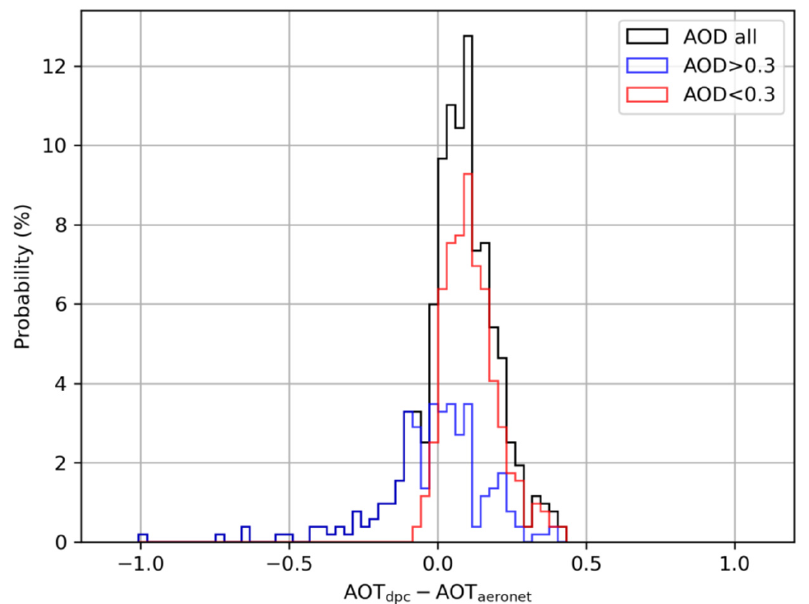
Figure 2. The probability density functions (PDFs) of the difference (AOD DPC —AOD AERONET ) be ‐ tween AOD values retrieved from DPC and AERONET (red color corresponds to PDF for AOD < 0.3, blue color corresponds to PDF for AOD > 0.3, black color shows their sum).